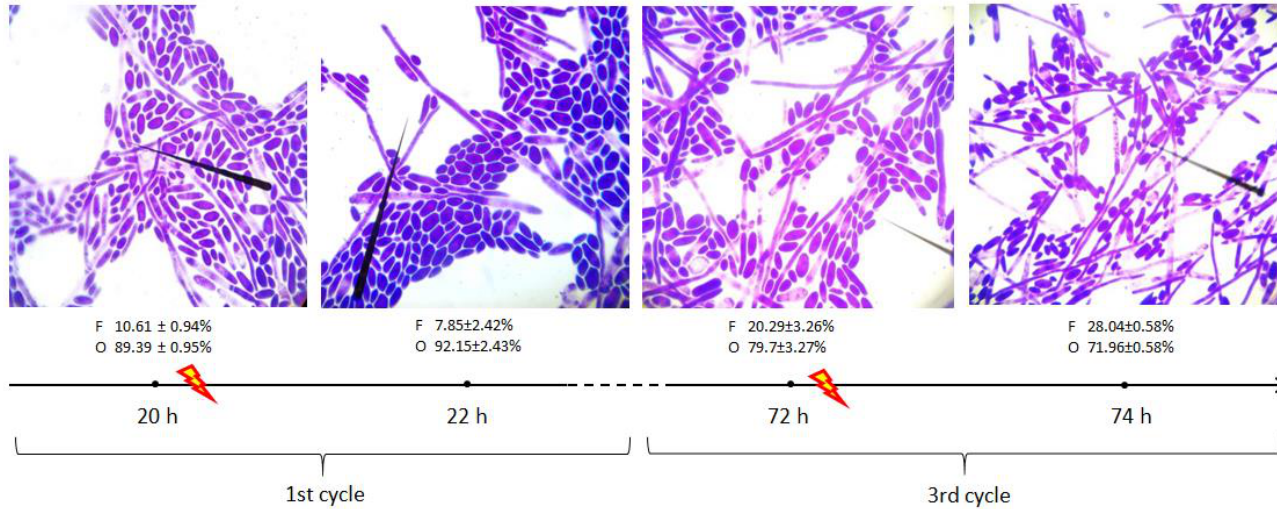
Figure 3. Representative images from light microscopy observations of Y. lipolytica cells in repeated-batch cultures at different stages. Magnification 1000 × (PrimoStar, Carl Zeiss light microscope). Mean percentage of filamentous (F) and ovoid forms (O) ± SD from five microscopic preparations.